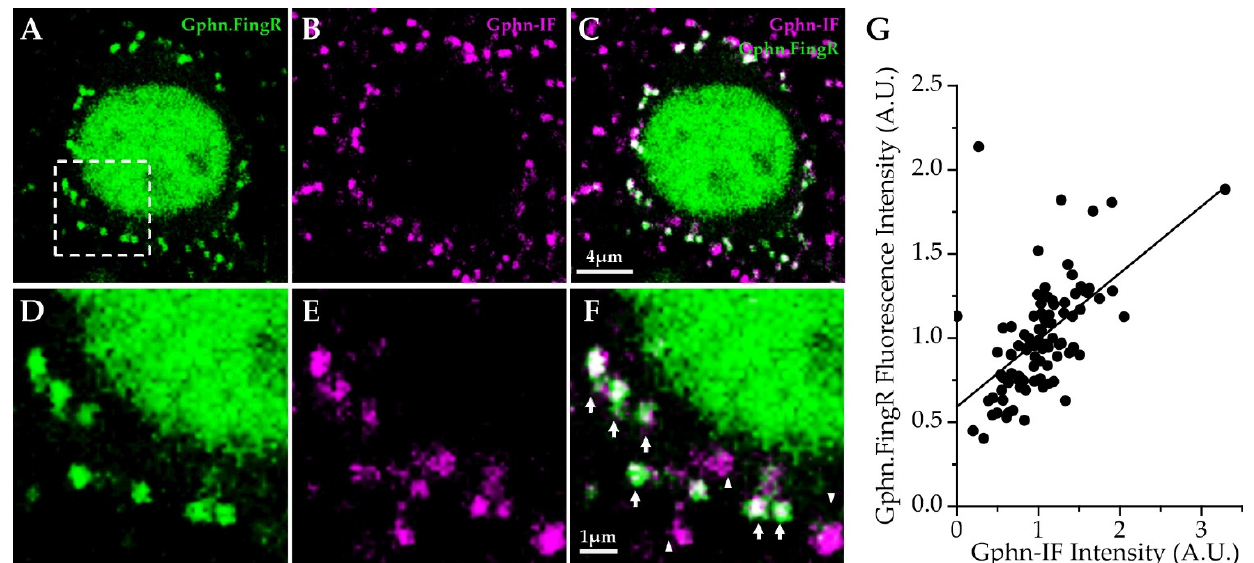
Figure 3. Correlated Gephyrin.FingR (Gphn.FingR) and gephyrin immunofluorescence (Gphn-IF) in neocortical Pyr neurons from mouse brain. ( A ) Optical section showing virally-transduced Gephyrin.FingR (green) puncta on a L2/3 Pyr neuron soma; ( B ) gephyrin-IF (magenta) signal for the same optical section in ( A ); ( C ) Gephyrin.FingR and gephyrin-IF for the same optical section in ( A ); ( D – F ) magnified images showing somatic signal corresponding to the boxed area in ( A ); arrows mark co-labeled puncta; arrowheads mark gephyrin-IF puncta that are not colocalized with Gephyrin.FingR. Since only a small fraction of cortical neurons express high levels of Gephyrin.FingR, the majority of inhibitory synapses in the brain show gephyrin-IF only; ( G ) Correlation plot for cell-normalized mean intensities of somatic Gephyrin.FingR and gephyrin-IF signal in L2/3 ( n = 4 cells) and L5 Pyr neurons ( n = 5 cells) from one animal.